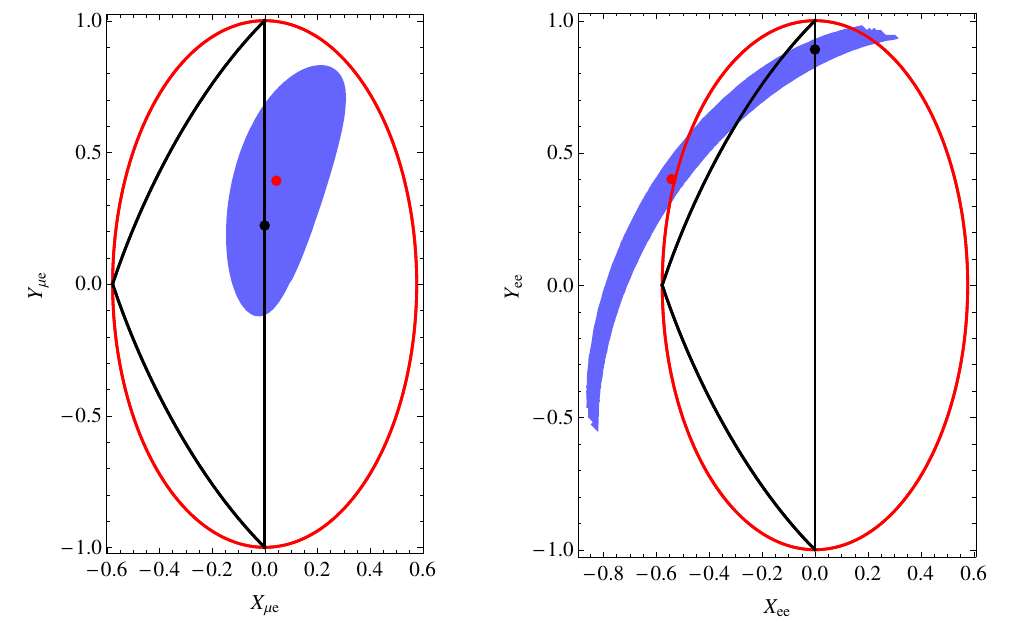
Figure 5 . Constraints from elastic neutrino scattering experiments in the (cid:22)e channel (left) and the ee channel (right). The blue regions correspond to 90% C.L. constraints from CHARM-II [39] ( (cid:22)e channel) and TEXONO ( ee channel). The black and red points represent the SM values and the best (cid:12)t. respectively. The black and red curves are the Majorana and Dirac bounds in eqs. (3.6) and